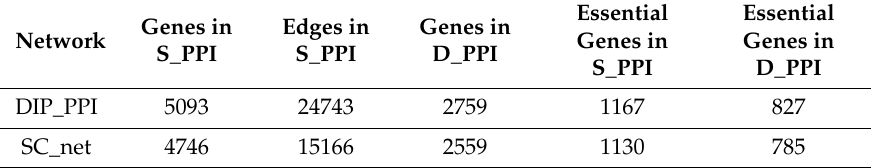
Table 1. Details of the two different yeast data sets. PPI: protein–protein